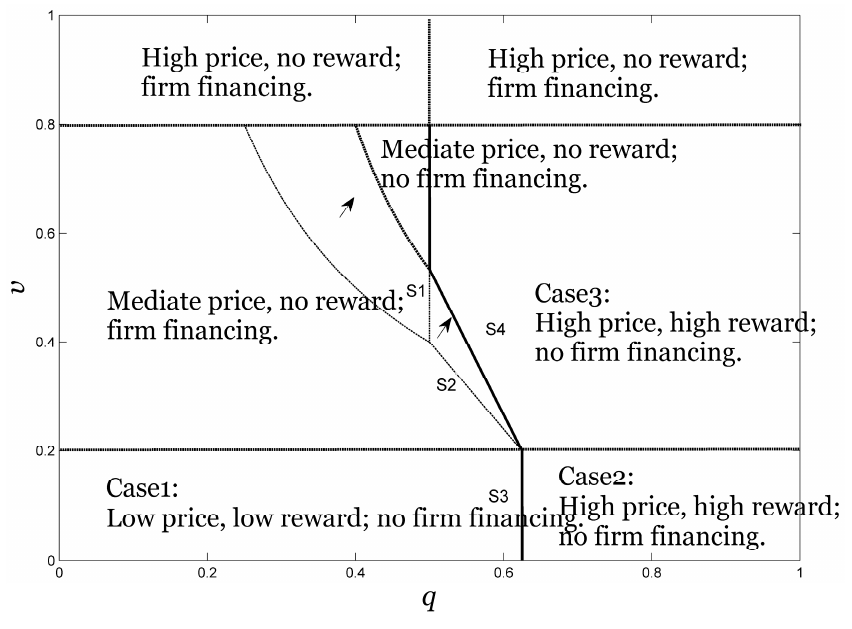
Figure 4. RRP and firm financing ( (cid:1834) (cid:3404) 0.8 , (cid:1838) (cid:3404) 0.2 , β (cid:3404) 0.5 and α (cid:3404) 0. 8